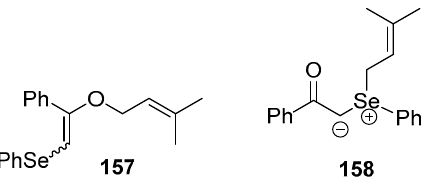
Figure 16. Enolate 157 and ylide 158 .